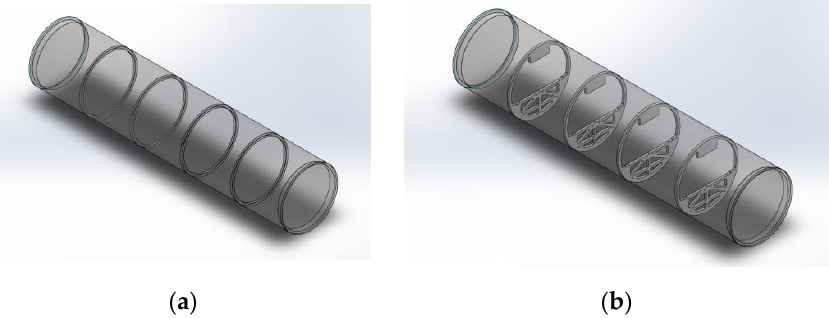
Figure 11. Geometries considered in the analyses: ( a ) four conventional stiffeners rigidly attached to the shell (Section 3), ( b ) shell with sliding stiffeners regularly spaced along the shell.